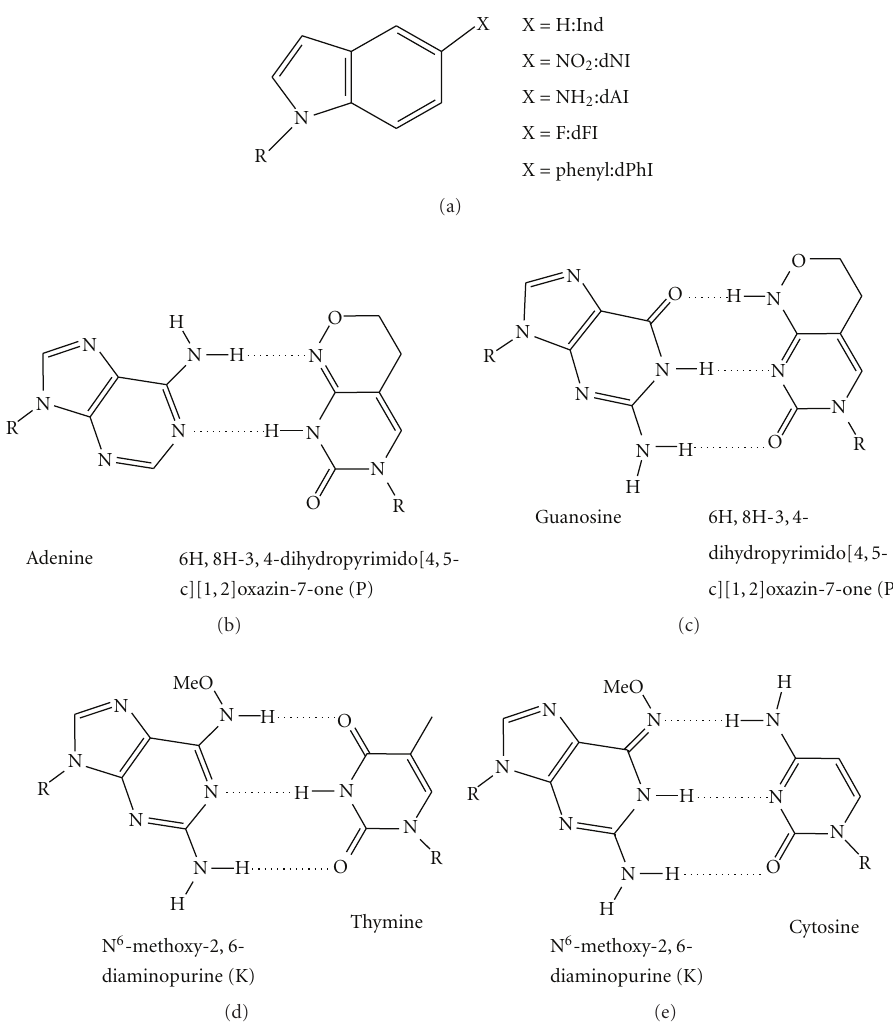
Figure 7: Purine and pyrimidine mimics. (a) Purine analogs based on the indole sca ff old: 5-substituted indolyl-2 (cid:2) deoxyriboside triphosphates where X = H, indole (Ind); X = NO 2 , 5-nitro-1-indole (dNI); X = NH 2 , 5-amino-1-indole (dAI); X = F, 5-fluoro-1-indole (dFI); X = phenyl, 5-phenyl-1-indole (dPhI) [95, 96]. ((b)–(e)) Pyrimidine mimic 6H,8H-3,4-dihydropyrimido[4,5-c][1,2]oxazin-7-one (P), and purine mimic N 6 -methoxy-2,6-diaminopurine (K) base pairing partners. (b) Adenine: P. (c) Guanosine:P. (d) Thymine:K. (e)